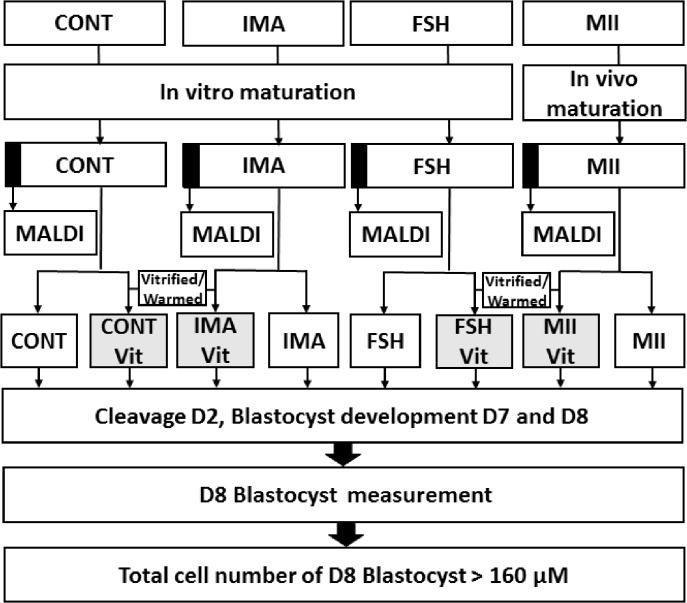
Experimental design flow diagram.Flow diagram of experimental design for the different treatments. Oocytes recovered from slaughterhouse ovaries (CONT), obtained by OPU from non-superstimulated females (IMA) and from superstimulated females (FSH) were matured in vitro. In vivo-matured oocytes were obtained by OPU from superstimulated females that received an ovulation inducer 24 hours previously (MII). A sample of matured oocytes from each of four groups was used to study the composition of plasma membrane phospholipids using MALDI-TOF. The remaining oocytes were divided in half, one half consisting of non-vitrified fresh oocytes (CONT, IMA, FSH and MII) and other of vitrified/ warmed oocytes (CONT Vit, IMA Vit, FSH Vit and MII Vit). At the end of the warming process, the eight groups were used for in vitro fertilization and culture. Cleavage at D2 and blastocyst development at D7 and D8 were evaluated. At D8, all of the blastocysts were measured, and those larger than 160 μM in diameter were stained for total cell number counting.